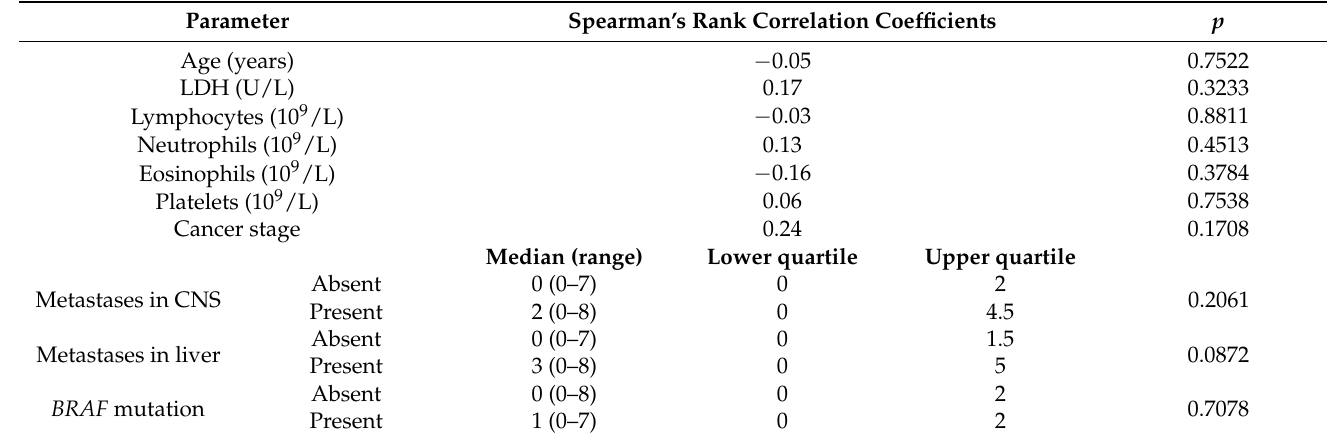
Table 2. Dependencies between CMC counts and clinical parameters.